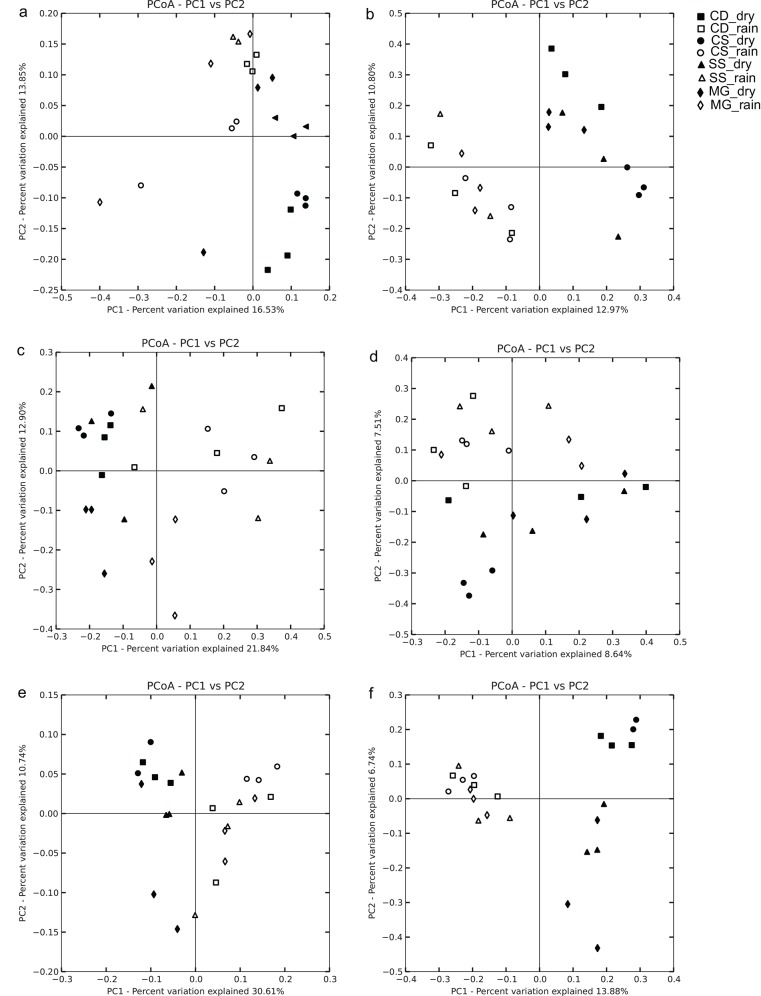
Principal coordinates analysis (PCoA) plots were generated for bacterial, fungal, and archaeal communities to visualize differences between the dry and rainy season and the four Cerrado physiognomies.Analysis of soil bacterial community structure based on (a) unweighted UniFrac distance and (b) Canberra distance; soil archaeal community structure based on (c) unweighted UniFrac distance and (d) Canberra distance; and soil fungal community structure based on (e) unweighted UniFrac distance and (f) Canberra distance. Markers represent replicate soil samples collected during the dry and rainy season in cerrado denso (CD, square), campo sujo (CS, circle), cerrado sensu stricto (SS, triangle), and gallery forest (MG, diamond) soils.